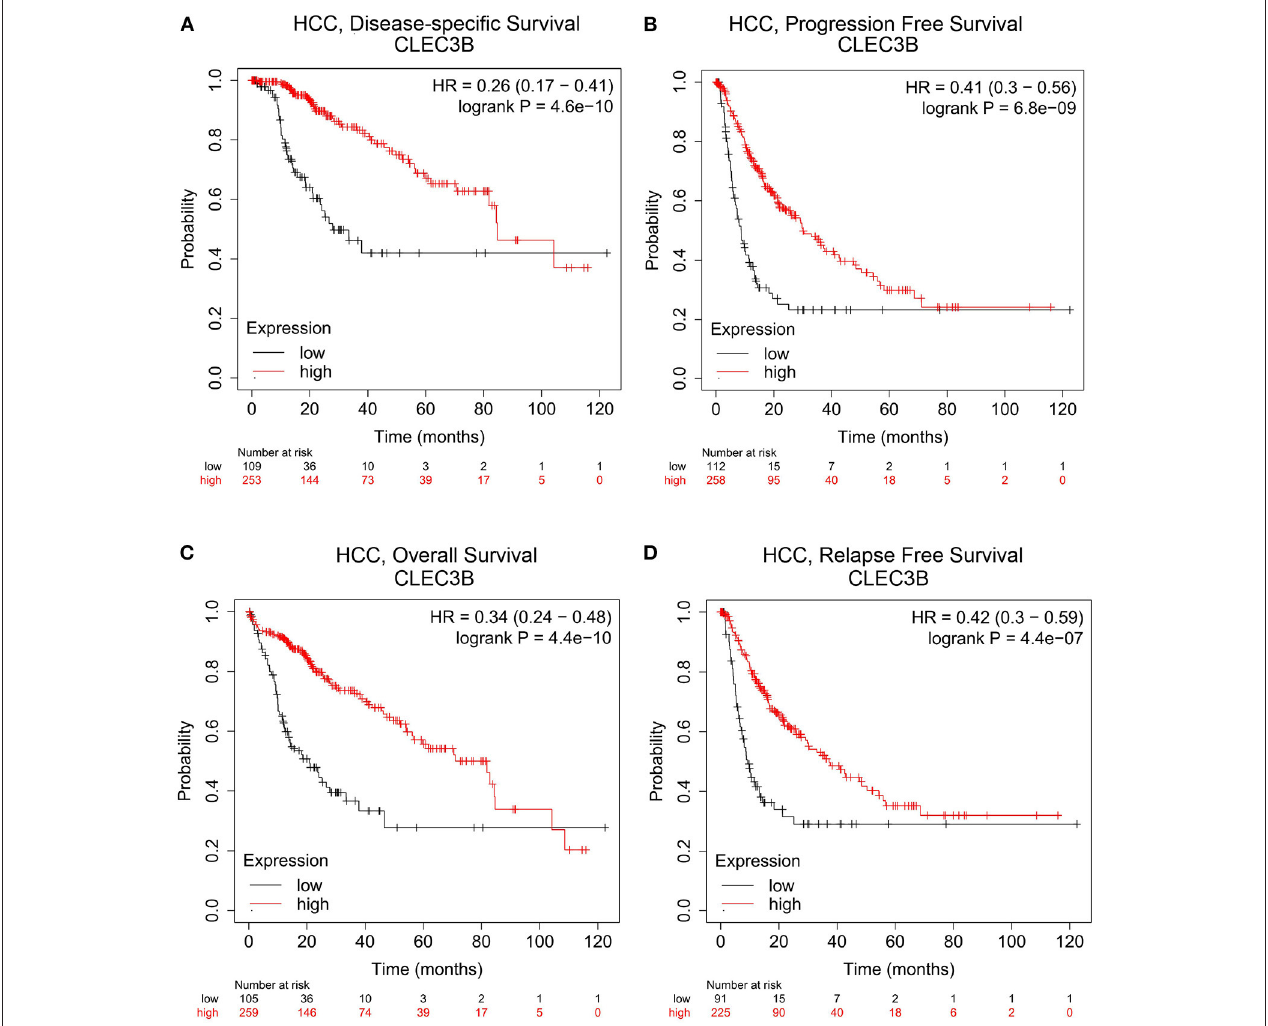
FIGURE 2 | Correlation analysis between CLEC3B expression and prognostic survival in HCC patients via Kaplan–Meier plotter analysis. (A) Disease-specific survival, n = 357; (B) progression-free survival, n = 366; (C) overall survival, n = 364; (D) relapse-free survival, n = 313.